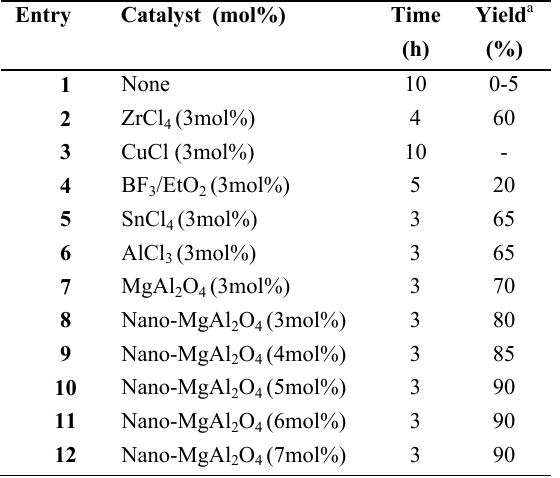
Table 1. In fl uence of different acid catalysts for the reaction of 2–methyl quinolines (1mmol) and benzoyl chloride (1mmol) under reflux